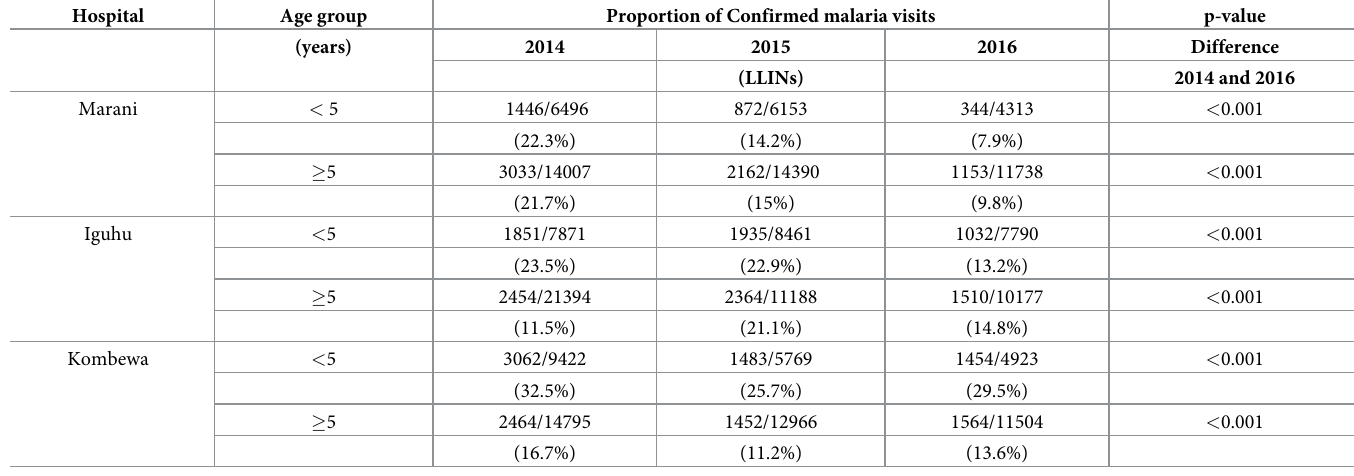
Table 6. Proportions of confirmed malaria to all outpatient department (OPD) visits from three hospitals located in areas with different transmission intensity of Western Kenya as from 2014 to 2016. Hospital